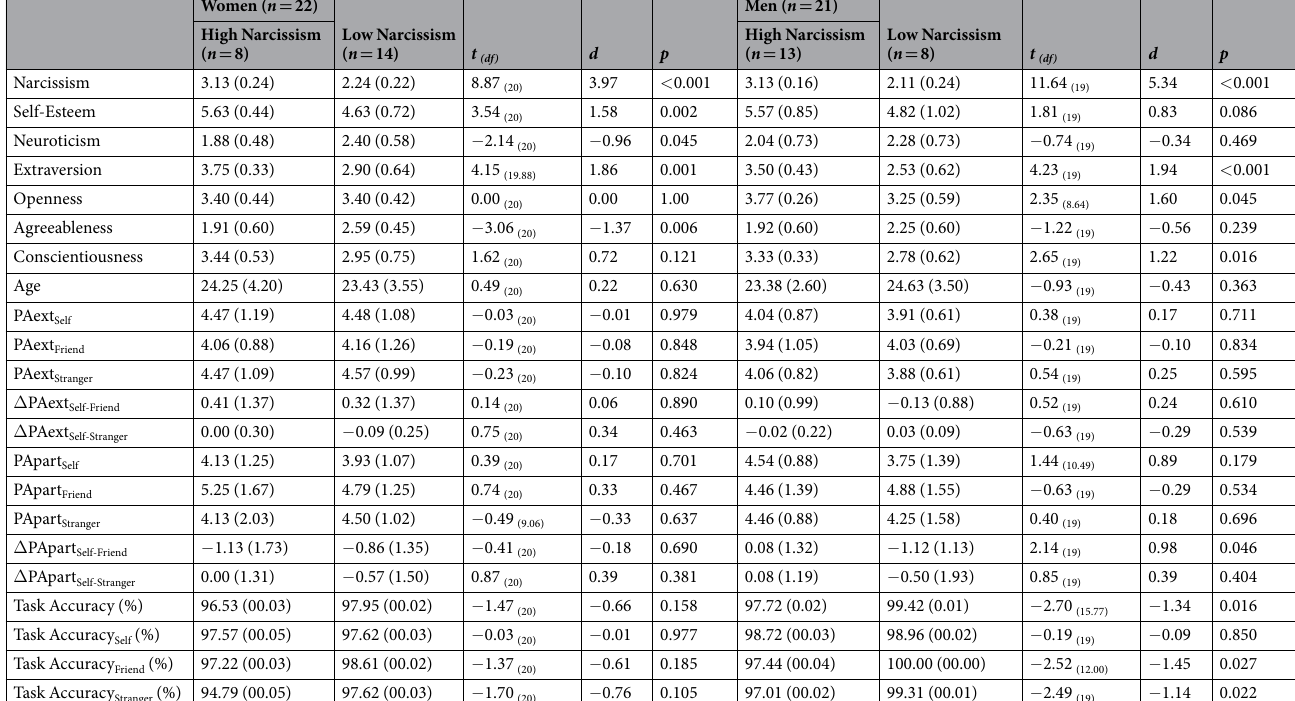
Table 1. Sample Characteristics. Note . PAext = Physical Attractiveness, external ratings; PApart = Physical Attractiveness, participant’s ratings. Corrected df were used in case of unequal variances.